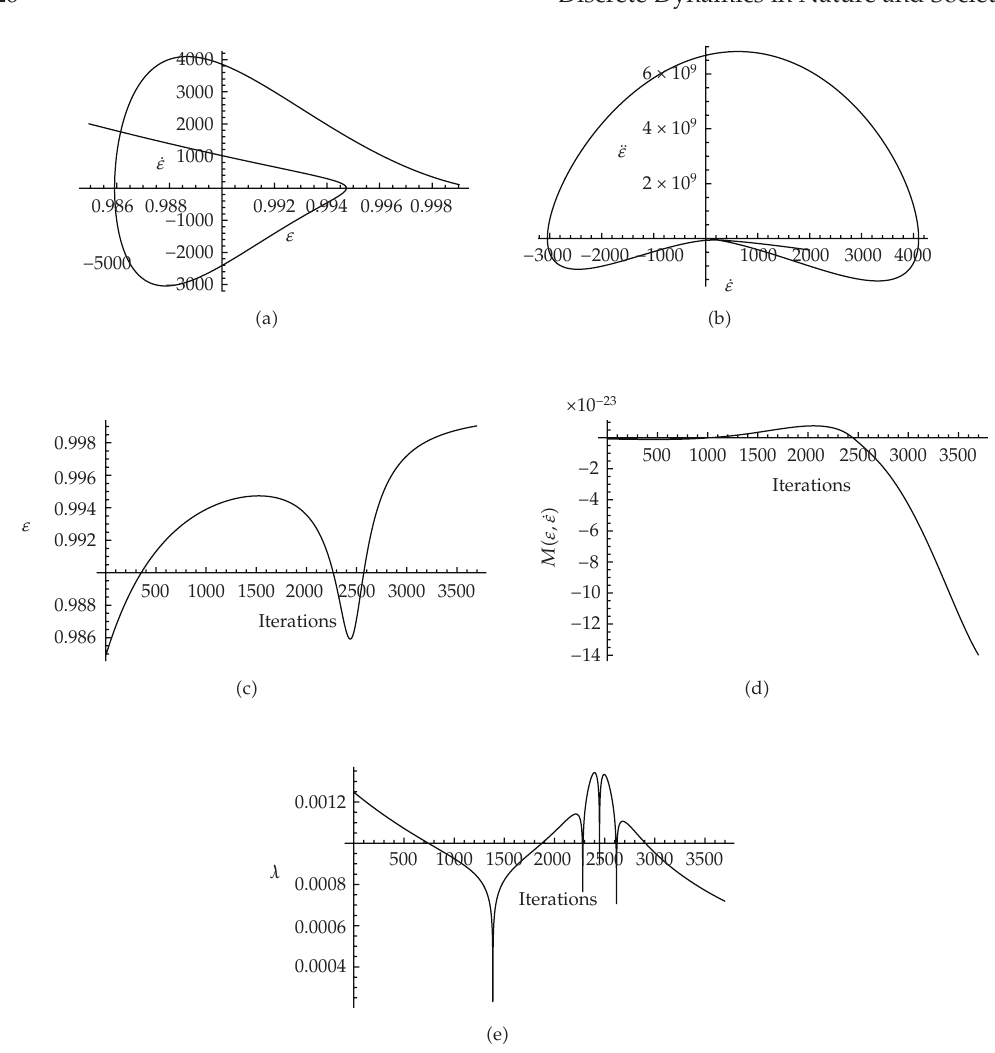
Figure 6: (cid:6) a (cid:7) and (cid:6) b (cid:7) The ε, ˙ ε and the ˙ ε, ¨ ε phase space graphs, respectively. (cid:6) c (cid:7) and (cid:6) d (cid:7) ε and the (cid:6) universal time (cid:7) e ff ective mass M (cid:6) ε, ˙ ε (cid:7) as functions of the number of iterations. As in the previous cycles, the mass fluctuation amplitude significantly grows towards the cycle’s end. One should also observe the relatively low value of the e ff ective mass around the iteration value of 2500 (cid:6) the climax of the cycle (cid:7) . (cid:6) e (cid:7) Again, the Lyapunov exponent fluctuates during the cycle and returns to decay